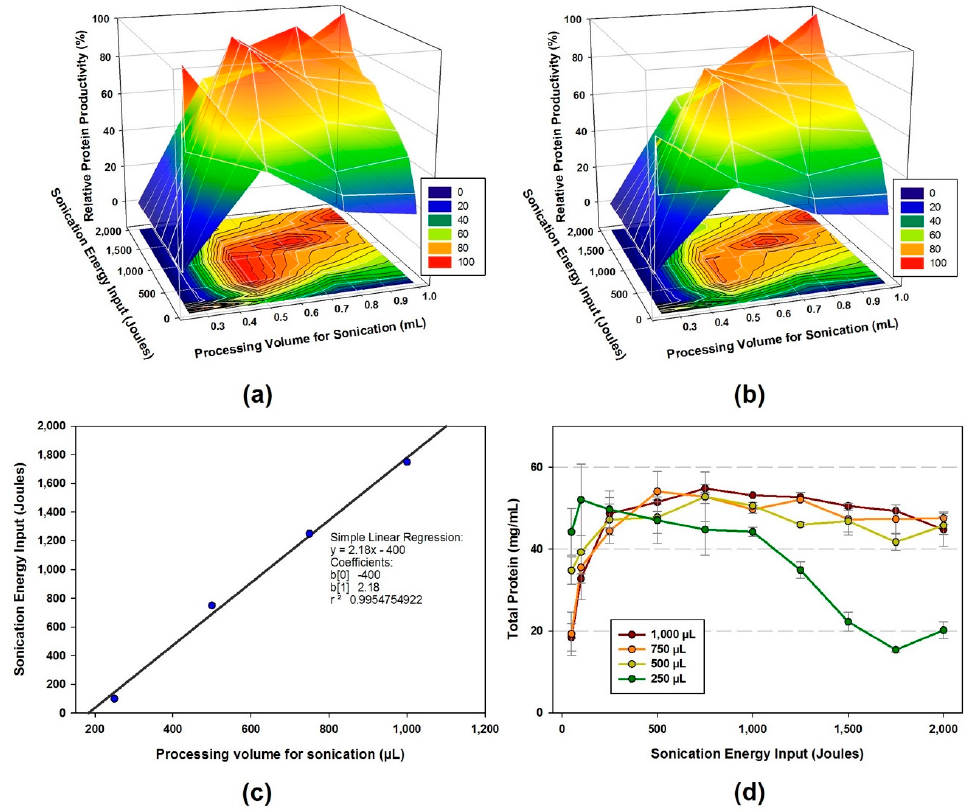
Figure 3. The effect of total energy input and cell suspension volume on the protein productivity of cell extract. ( a ) The relative protein productivity per each volume. The productivity was represented from 0 to 100% at each processing volume (250, 500, 750, and 1000 μ L) by different energy input (from 50 J to 2000 J) to find the optimal sonication energy input for each processing volume. ( b ) The relative protein productivity with all processing volume (250 to 1000 μ L, combined) was represented from 0 to 100% by different energy input (from 50 J to 2000 J) to find the optimal sonication energy and volume for the highest protein productivity. ( c ) A simple linear regression model of processing volume and sonication energy input. The sonication energy input resulting in the highly active cell extract was selected for each processing volume (250, 500, 750, and 1000 μ L) and plotted in a regression model. From the regression model, the optimal energy for each processing volume can be calculated as follows: (Sonication energy input (Joules)) = (The designed processing volume for sonication ( μ L) + 400) 2.18 − 1 . ( d ) The changes in the total protein amount of the cell extract in different sonication energy input. Data are presented as the average ± standard deviation ( n = 2). 4.3. Post-Lysis Procedure Runoff reaction and dialysis were considered as cell extract clarification steps in traditional cell extract preparation. However, commercially available E. coli strain BL21 showed robust cell extract performance without these additional processes after lysis [19]. Kwon and Jewett further optimized a correlation between runoff reaction time and cell extract performance for E. coli strains BL21(DE3) star and a partially engineered C495 [22]. Here, we investigated the effect of runoff reaction and dialysis on the protein productivity of cell extract derived from genomically engineered E. coli strain. The different runoff reaction was conducted after lysis and centrifugation. The CFPS reaction was carried out for 20 h at 30 °C with pJL1-sfGFP and PCR amplified linear sfGFP template. The data on protein productivity by different runoff time in Figure 4a,b shows that the runoff reaction time is